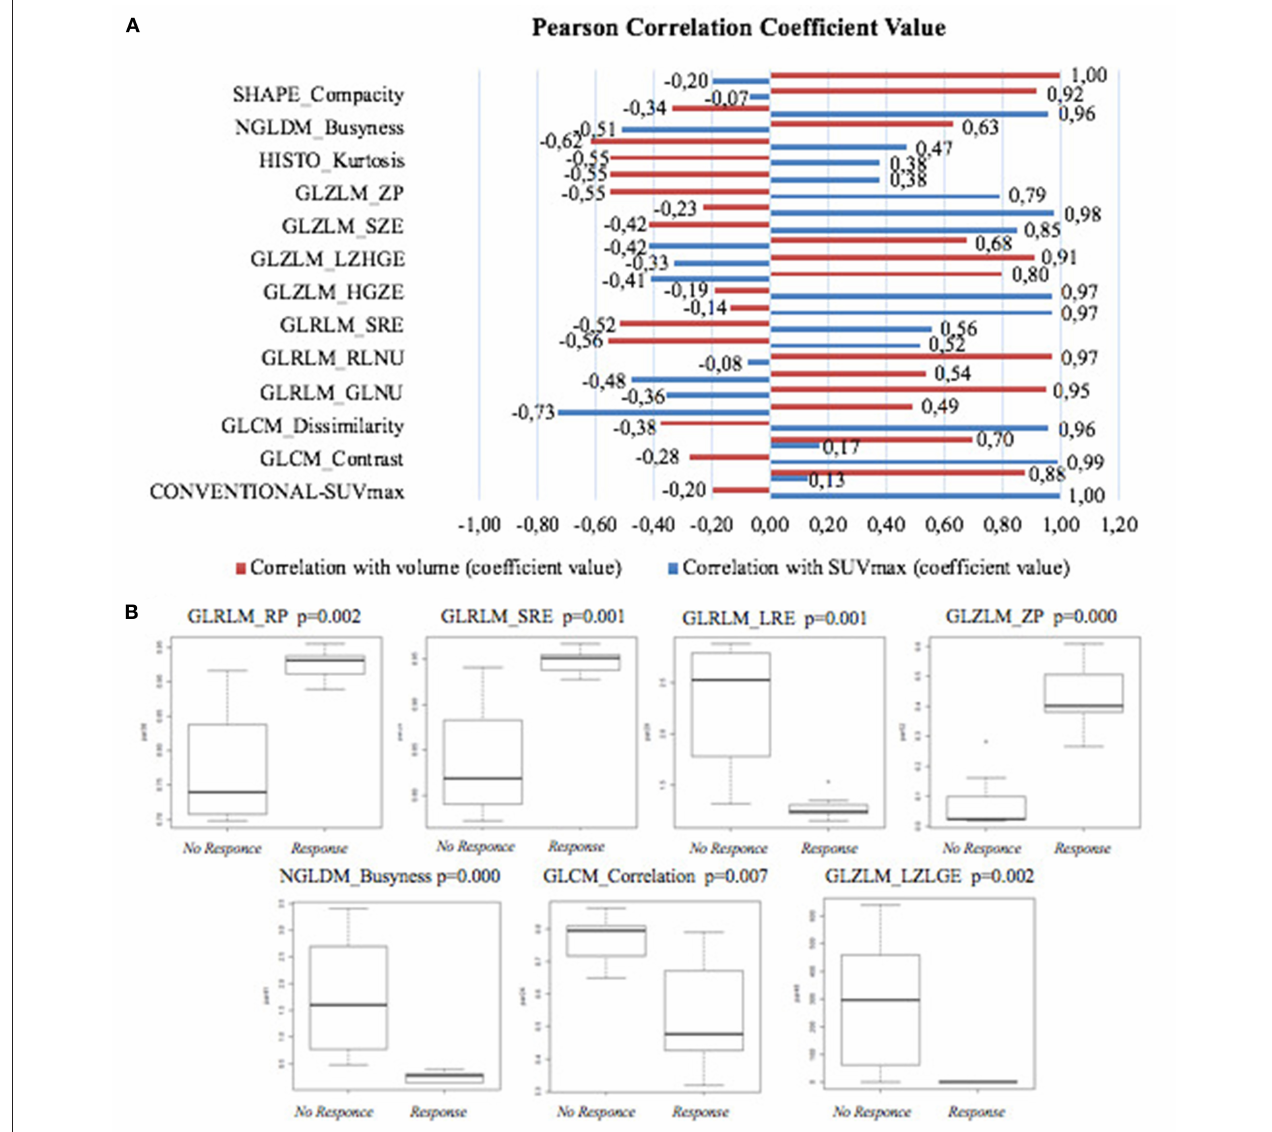
FIGURE 3 | (A) Pearson correlation coefficients between radiomic features and SUVmax and volume (ml), respectively. (B) Boxplot of the second-order features not correlated with both SUVmax and volume in non-responder and